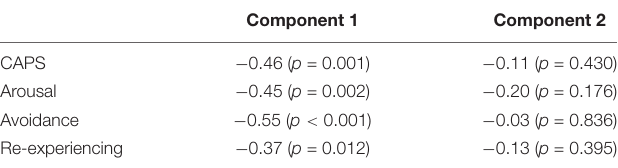
TABLE 4 | Correlation between symptom severity and individual contributions. Component